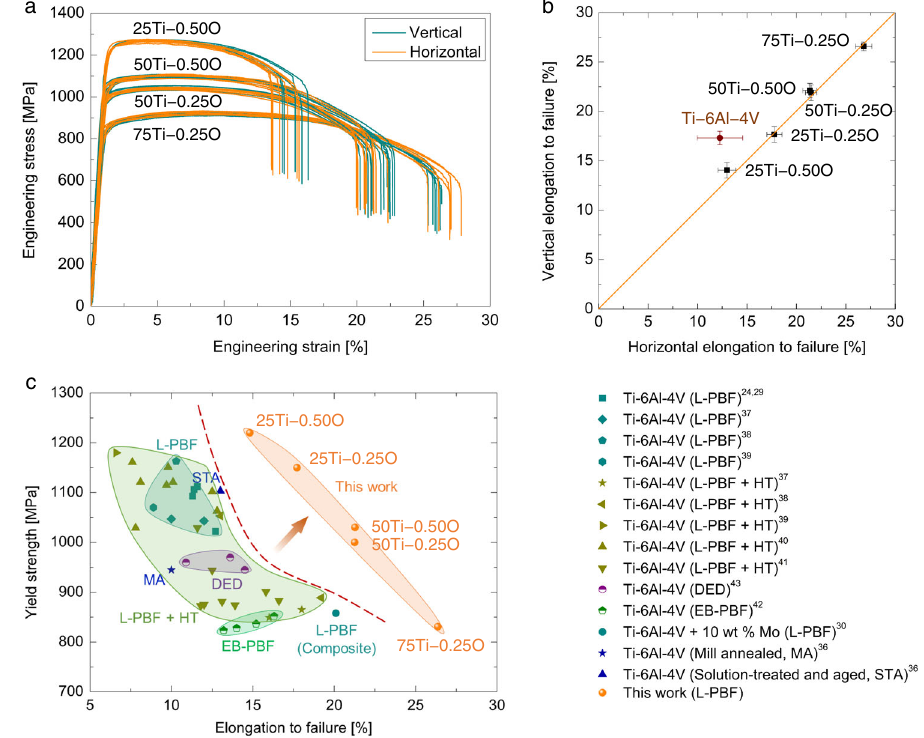
Fig. 3 | Mechanical properties of the newly developed alloys fabricated by L-PBF. a Tensile engineering stress-strain curves along the vertical and horizontal directions, indicating uniform tensile properties. b The elongation to failure of Ti − 6Al − 4V and the newly developed alloys along the vertical and horizontal directions. The signi fi cant data deviation of Ti − 6Al − 4V from the orange line